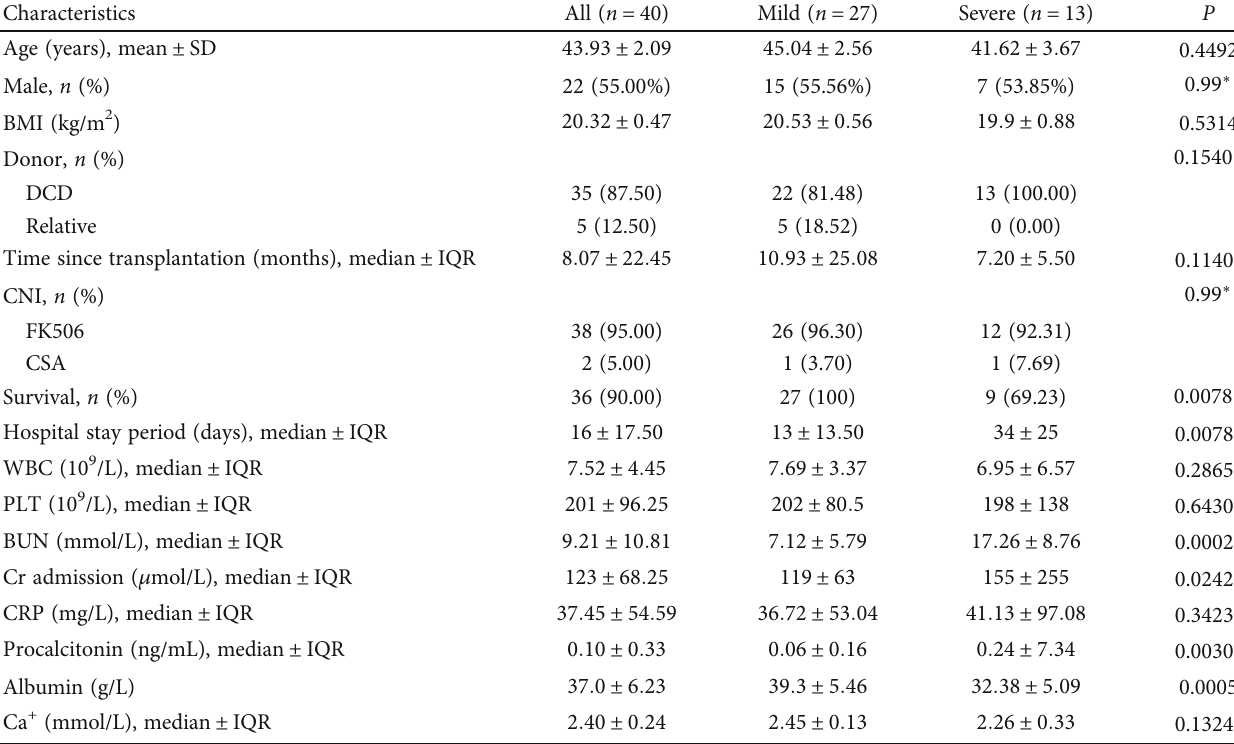
Table 2: Clinical characteristics of the patients.